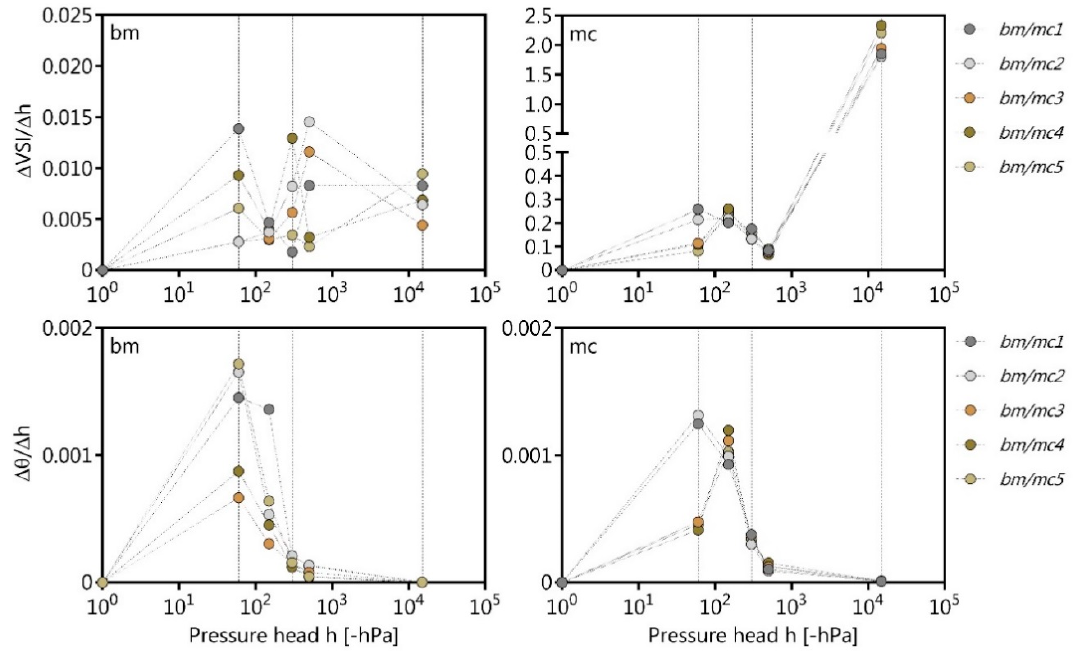
Figure 4. Observed pore size distribution as ratio of changing volumetric water content ( θ ) and pressure head (h) and pore size distribution (PSD)-dependent volume change as ratio volume shrinkage index (VSI) and pressure head (h) of the boulder marl (bm) and the marsh clay (mc) of five different Proctor stages (1–5).